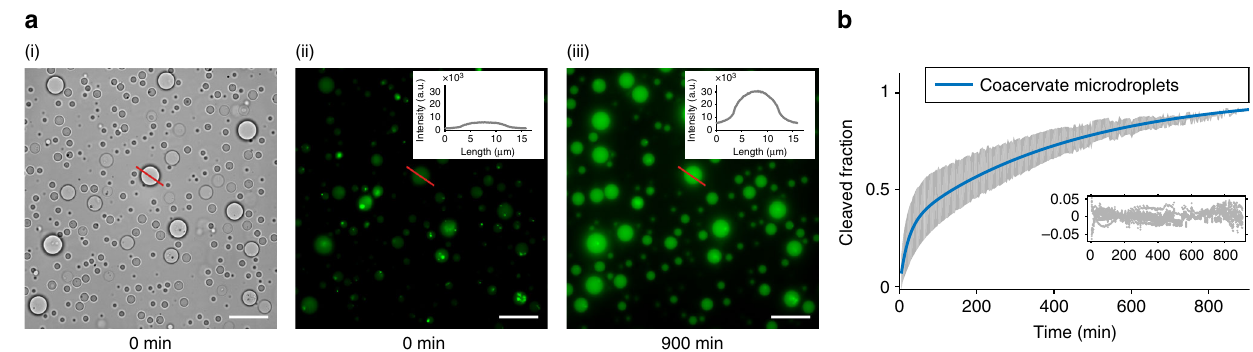
Fig. 3 RNA catalysis in coacervate microdroplets. a (i) Wide- fi eld optical microscopy images of CM-Dex:PLys (4:1 fi nal molar ratio) coacervate microdroplets prepared in cleavage buffer (1 μ M of HH-min and 0.5 μ M FRET substrate). Fluorescence microscopy images at t = 0 min (ii) and t = 900 min (iii) show an increase in FAM fl uorescence (see inset). Scale bars are 20 μ M. b Background corrected and volume/endpoint normalised fl uorescence intensity of droplets. Standard deviation of kinetics from 12 micro-droplets (grey) with the mean biexponential fi t (blue) and residuals 50 µl of phase under single turnover conditions (1 µM of HH-min and 0.5 µM FRET substrate). Fluorescence optical microscopy